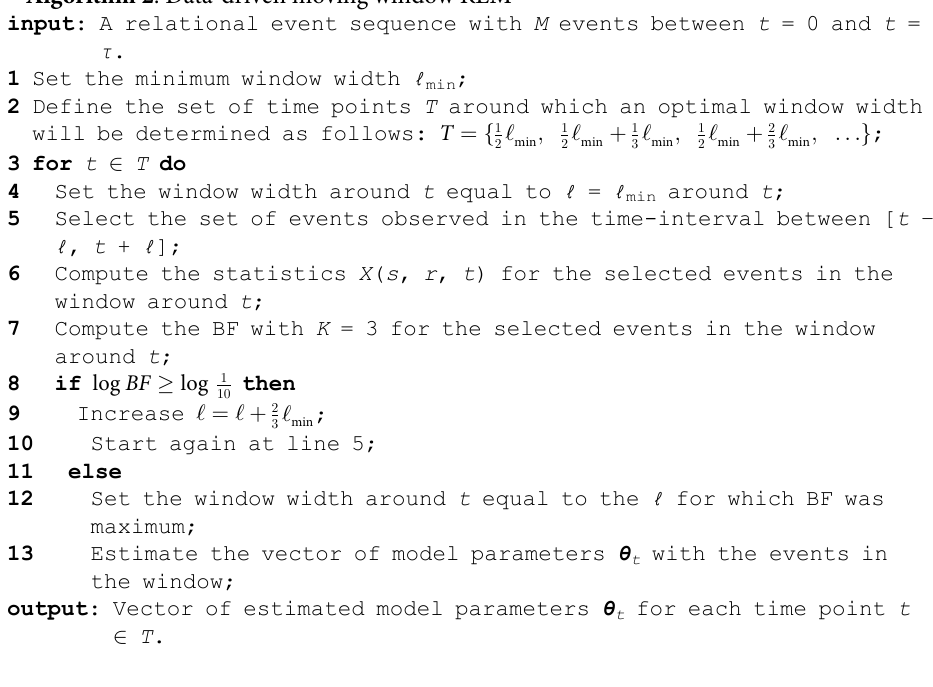
Algorithm 2 : Data-driven moving window